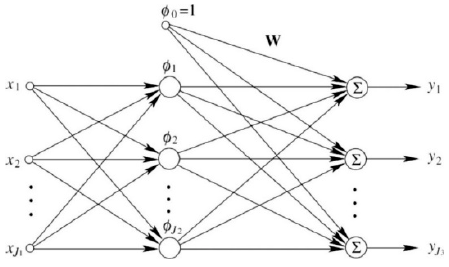
Figure 2. Schematic of radial basis function neural networks [31].